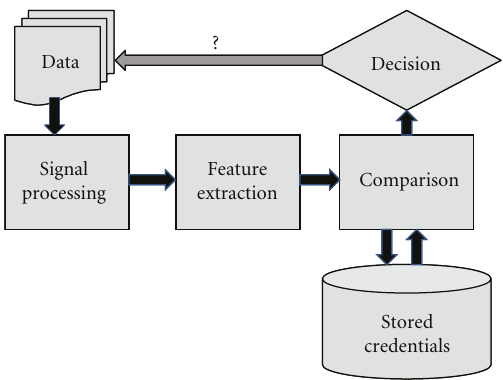
Figure 1: Simplified architecture for an authentication